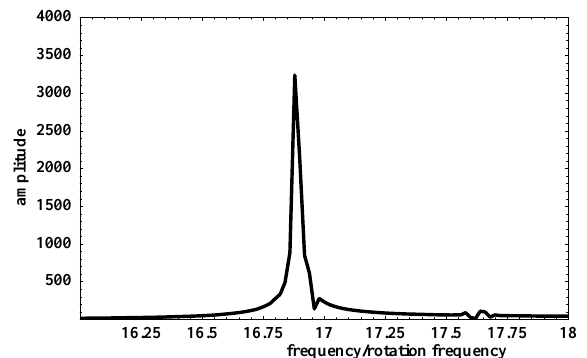
FIG. 16. Spectrum of (cid:5) y 3 (cid:6) at 1000 turns for (cid:1) n x , n y (cid:2) (cid:1) (cid:1) 5.74, 5.71 (cid:2) .